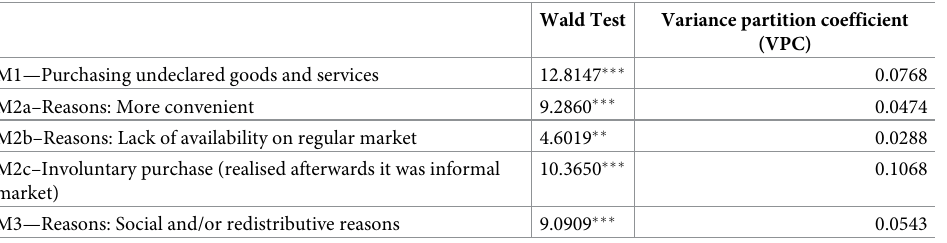
Table 1. Baseline random intercept model–no explanatory